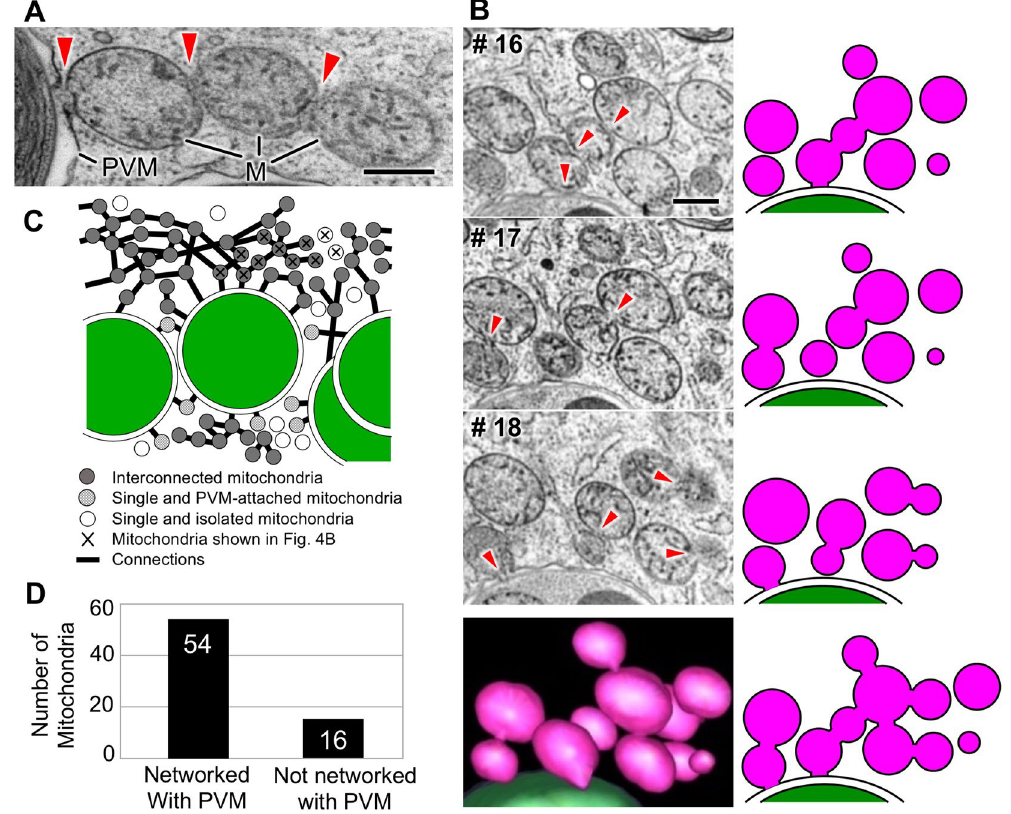
Figure 4. The mitochondrial network around the symbiotic zoochlorella in P . bursaria . ( A ) A TEM image of the mitochondrial network associated with the PVM in P . bursaria . The arrowheads indicate the connections between adjacent mitochondria. ( B ) TEM images of the mitochondrial network in the 15th, 16th, and 17th ultrathin sections of P . bursaria , and the corresponding 2-D models of this region of the cell. The arrowheads indicate the connections between adjacent mitochondria. The lower panel shows segmentation in 3-D reconstruction and its corresponding 2-D image. The mitochondria and the symbiotic zoochlorellae are colored by pink and green, respectively. ( C ) A schematic drawing of the direct connections formed by all 70 mitochondria present in the 3-D model. ( D ) A histogram showing the numbers of mitochondria that are directly or indirectly associated with the PVM (shown as filled and shaded circles in Fig. 4C), and those that are not incorporated in the PVM-associated mitochondrial network (shown as open circles in Fig. 4C). Scale bars: 500 nm. M, mitochondrion; PVM, perialgal vacuole